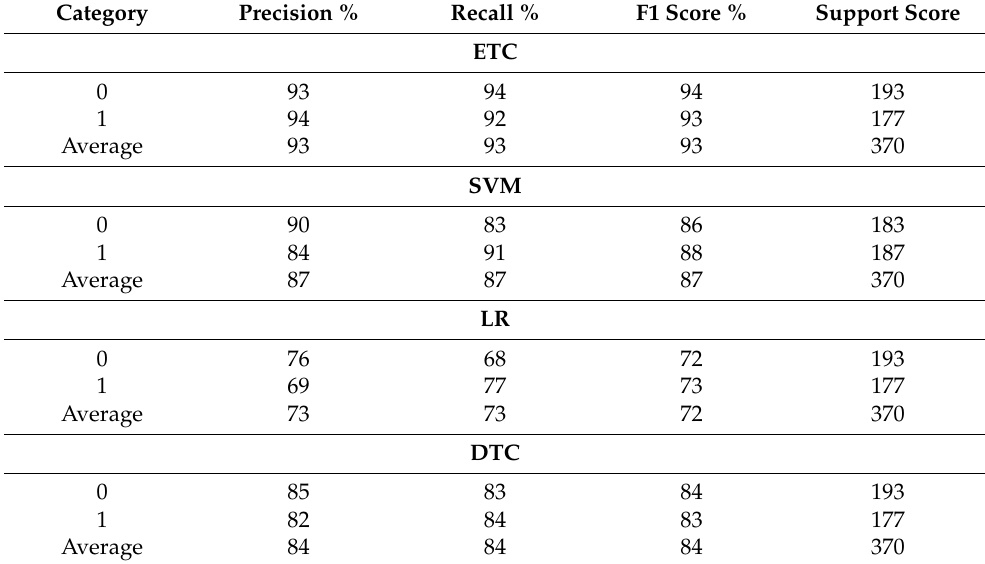
Table 4. The employed approaches classification report analysis of performance metrics by category and in the average case.